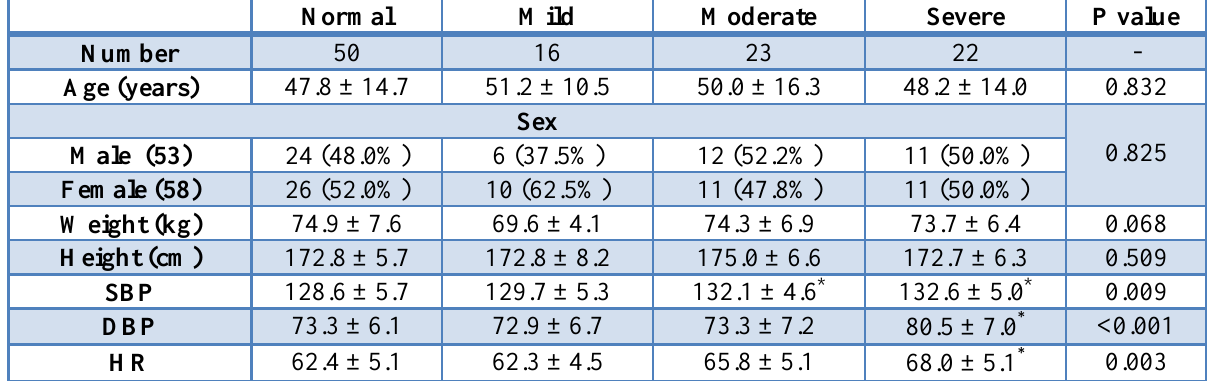
Table 1: Demographic and clinical data of the study population (n=111)